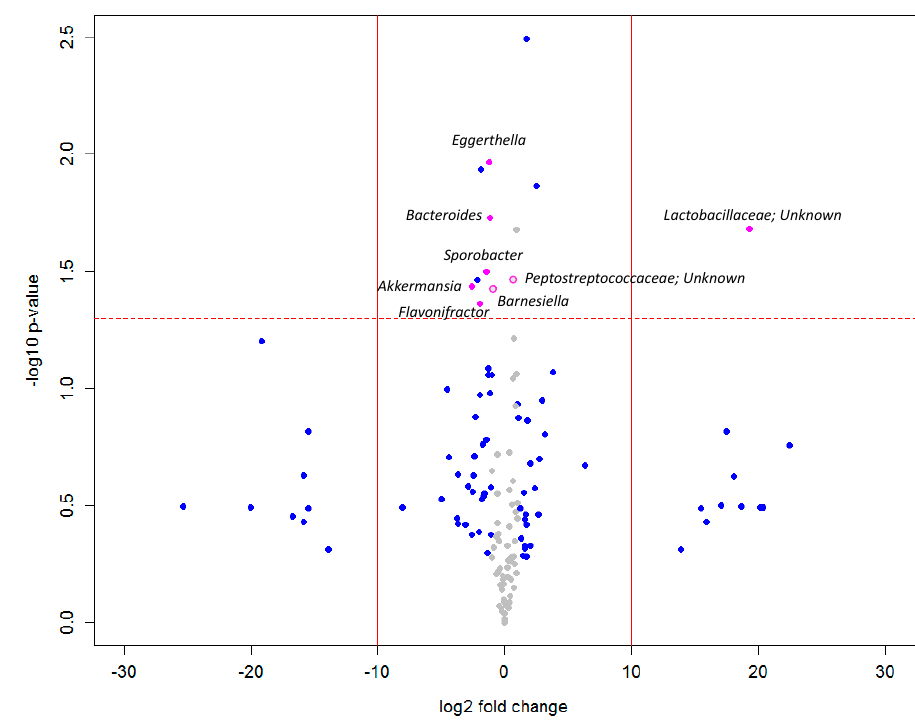
Figure 1. The overall difference of gut microbiota between autism spectrum disorders (ASD) and neurotypical (NT) individuals was assessed. A negligible number (0.000001) was added to the mean abundance of every bacterium to avoid the value of magnitude of fold change being infinitely large or small. This number was calculated based on the one hundredth of the minimal relative abundance in either group. Each point represents a bacterium with its magnitude fold change in relative abundance (log2 of ASD/NT) on the x -axis and the value of statistical significance ( − log10 of p value) on the y -axis. The dashed red line shows where p = 0.05, with points above the line having p < 0.05 and points below the line having p > 0.05. Points with magnitude of fold change less than 1 are shown in grey. Points outside of the solid lines are bacteria with mean abundance of 0 in either ASD (left) or NT (right) group. Bacteria significantly altered in abundance in addition to the findings in Strati et al. were colored or circled in pink.